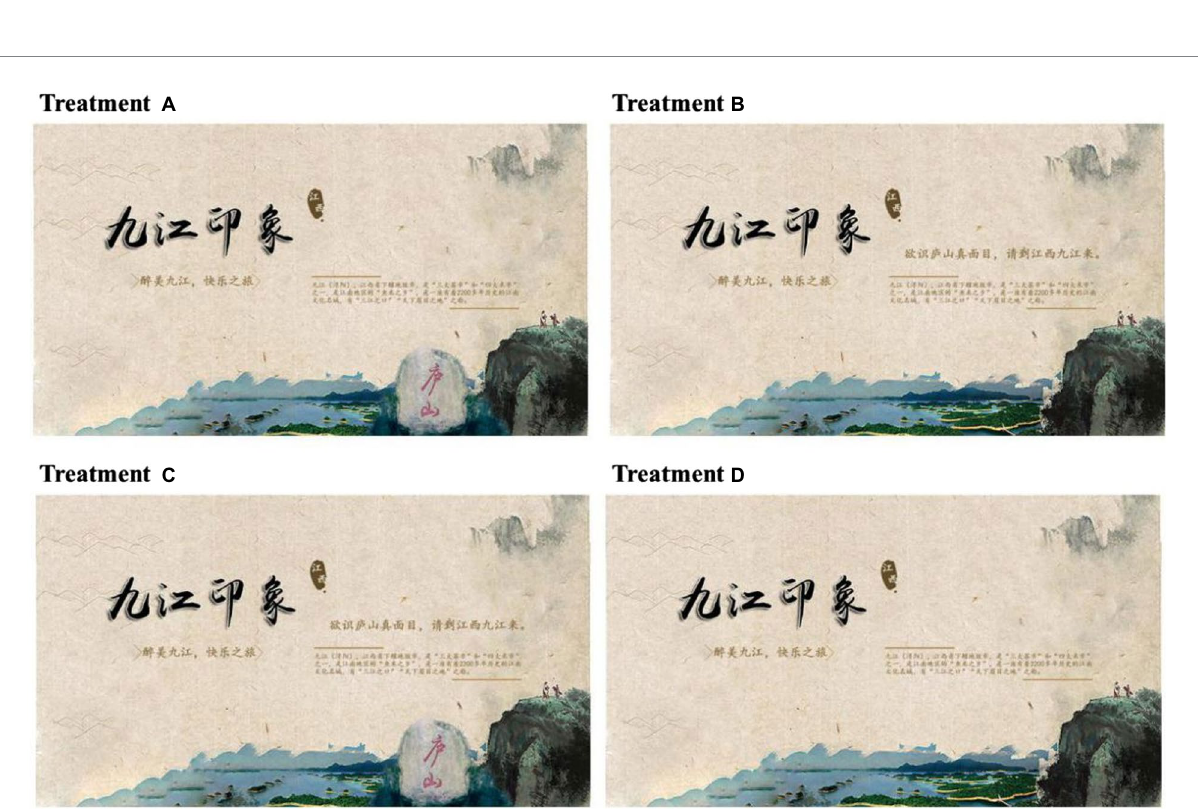
FIGURE 2 Stimulus materials. Source: made by one of authors using Photoshop software based on the true tourism advertisement. The main body of the advertisements includes image and text parts, and the basic elements of the image part are the ink painting of Mount Lu at the bottom right of the advertisement and the lake at the bottom center. The basic elements of the text part are “Jiujiang Impression,” the slogan that Jiujiang is the most beautiful city in China, and the introduction of Jiujiang City on the right side, which says Jiujiang is a prefecture-level city under Jiangxi Province. Jiujiang is one of the three major tea markets and one of the four major rice markets. It is the hometown of fish and rice in the Jiangnan region as a famous cultural city in Jiangnan with a history of more than 2,200